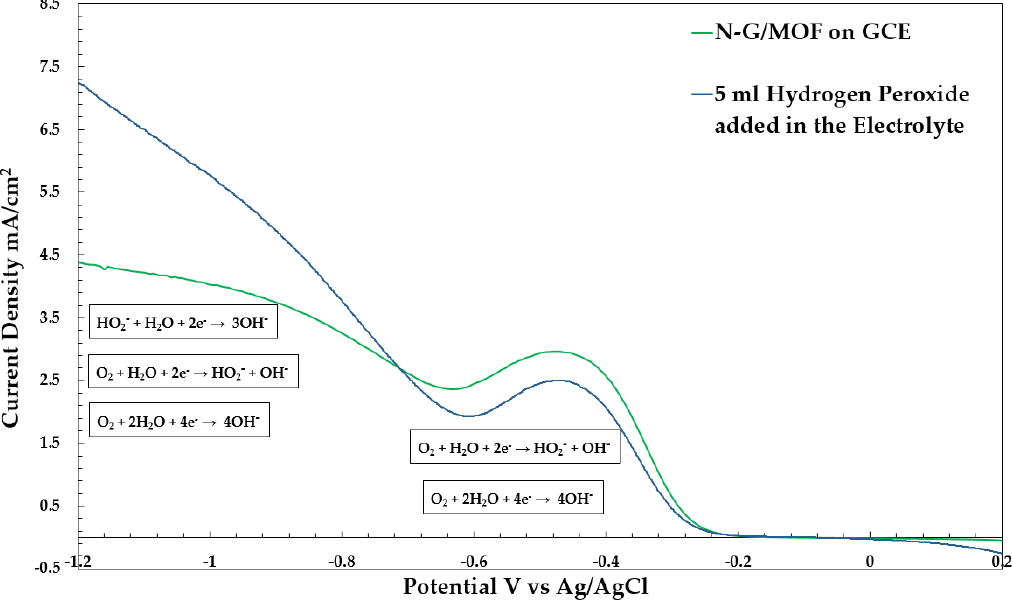
Figure 2. LSV plots for ORR from without (green line) and with (blue line) H 2 O 2 in oxygen saturated 0.1 KOH electrolyte on the N-G/MOF coated GCE working electrode.